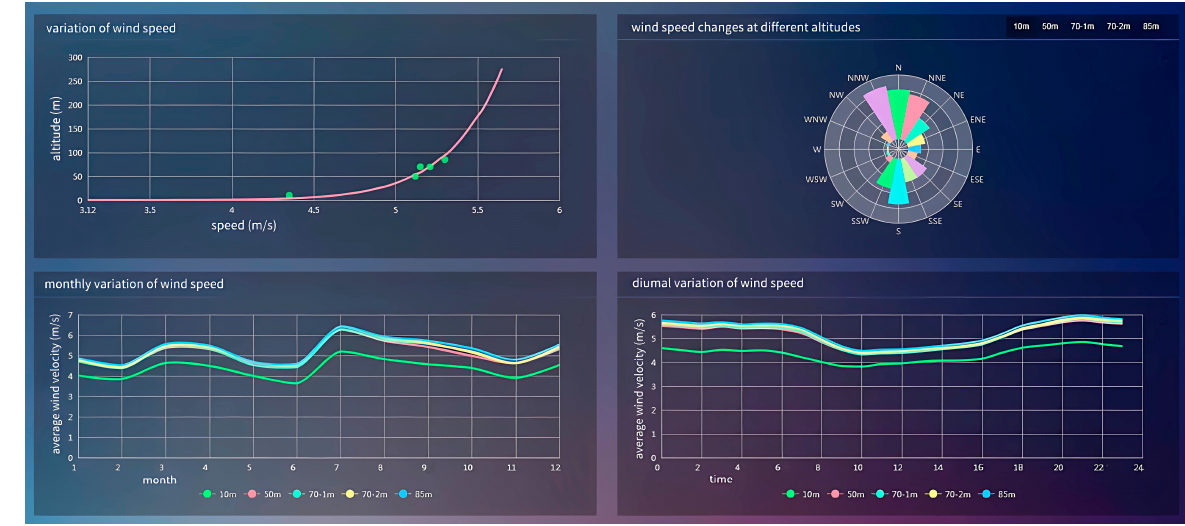
Figure 6. Wind Measurement Tower Module.